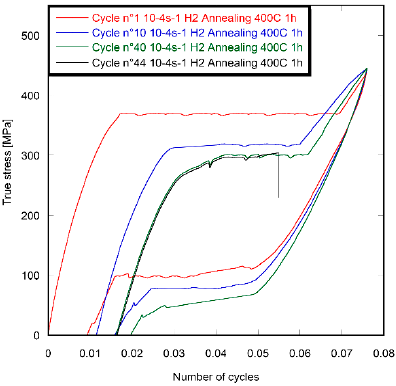
Figure 9. Tensile loading and unloading of annealed specimen for 1 h at 400 °C after immersion and ageing.